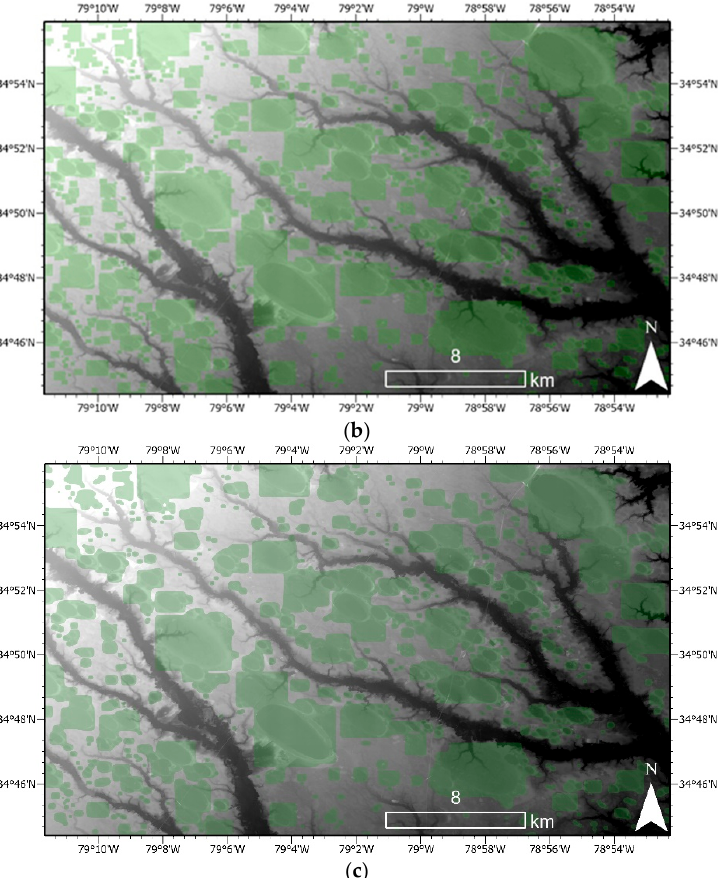
Figure 23. ( a ) Carolina Bay detections at various image footprint scales. ( b ) Aggregation of over- lapping detections. ( c ) PAEK-smoothed polygons.